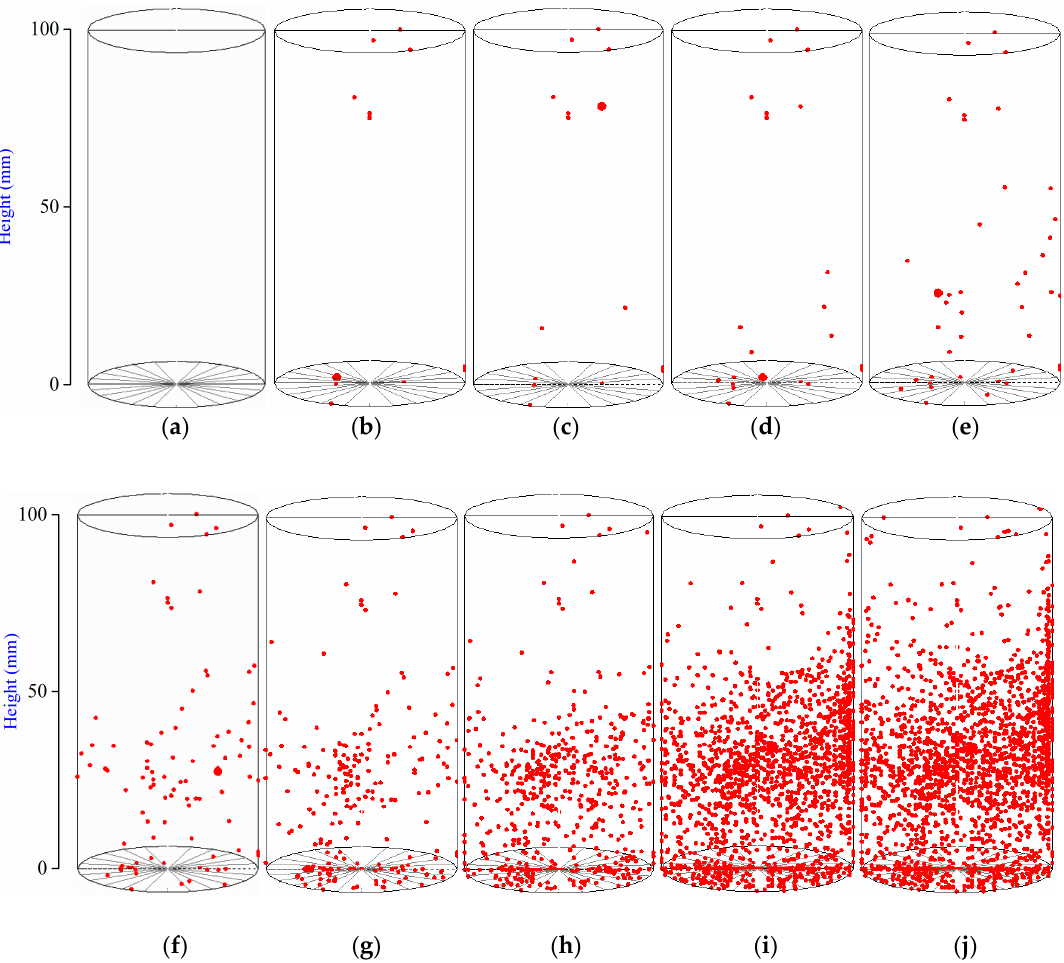
Figure 8. Distribution of AE events of the R-C sandwiched coal-rock specimen during the load process. The letters shown in the figure correspond to the purple markers of Figure 7b. ( a ) 0 s; ( b ) 100 s; ( c ) 200 s; ( d ) 300 s;( e ) 400 s; ( f ) 500 s; ( g ) 600 s; ( h ) 700 s; ( i ) 800 s; ( j ) 827 s.